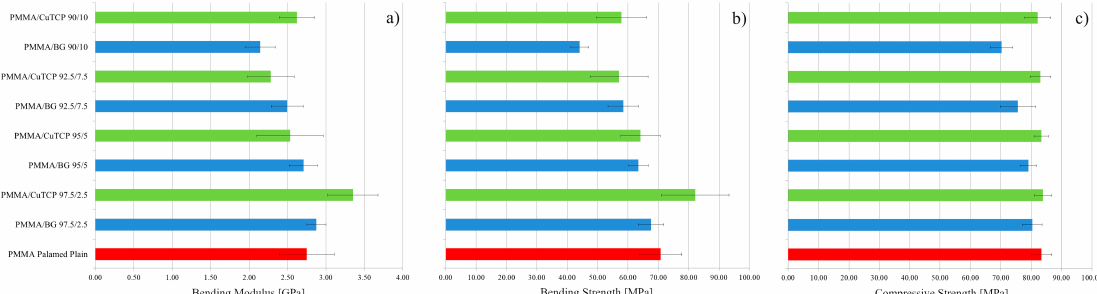
Figure 2. Mechanical properties of PMMA, PMMA / BG and PMMA / CuTCP composites. ( a ) Bending modulus; ( b ) bending strength; ( c ) compression strength.